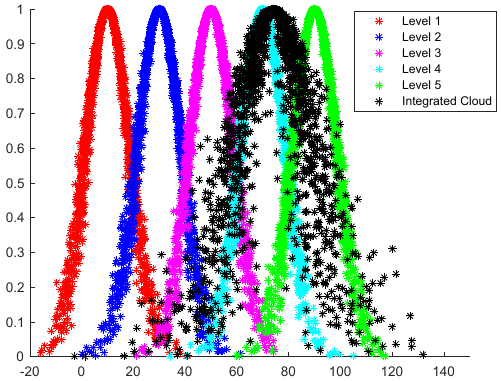
Figure 10. Construction technology risk integrated cloud vs. standard cloud.